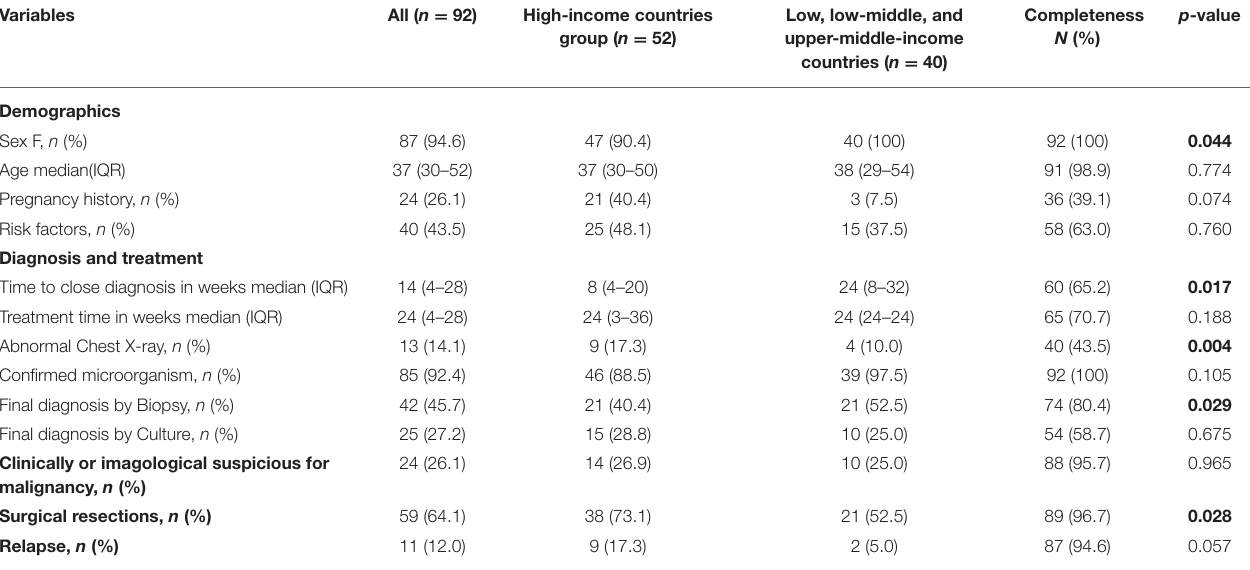
TABLE 4 | Population characteristics, clinical, diagnostic management, and treatment according to high and middle/low-income countries. Variables All ( n = 92) High-income countries group ( n =